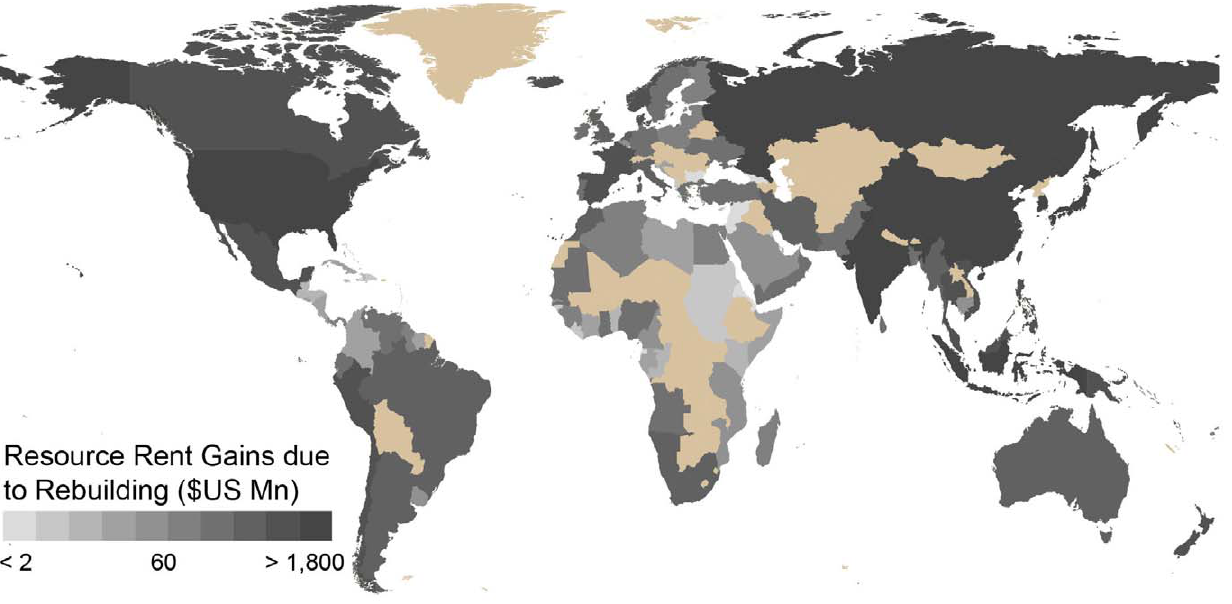
Figure 2. Summary of resource rent (adjusted for subsidies) from rebuilt fisheries (rent in all maritime countries increase after rebuilding).